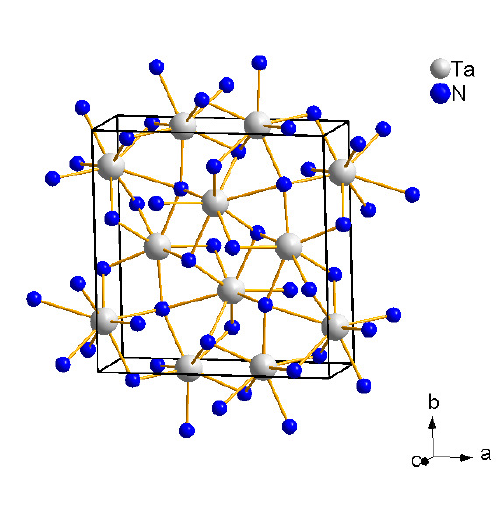
Figure 6. Crystal structure of η -Ta polyhedra [32].